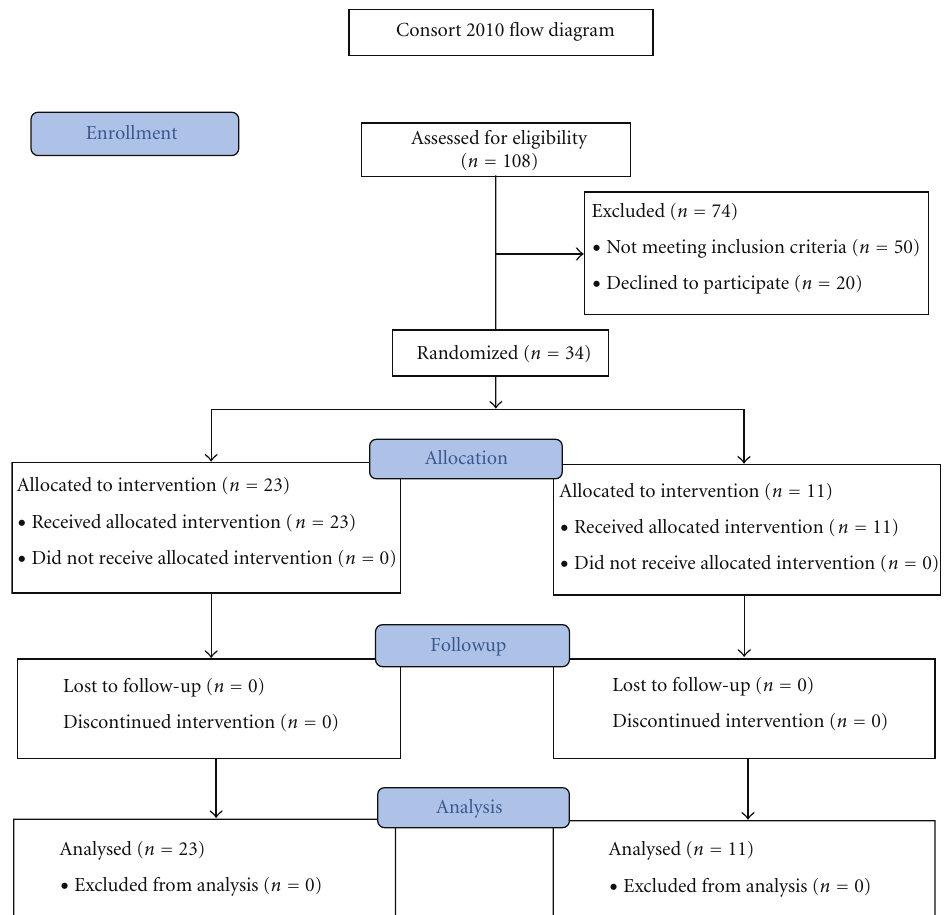
Figure 1: Flow chart of subject enrollment and treatment. One hundred eight MS subjects were screened, with 67 testing positive for expression of HLA-DR2. Of these, 29 failed additional screening (did not meet EDSS requirement, were taking exclusionary drugs, or had a surgical procedure) or declined entry and 38 were enrolled in the